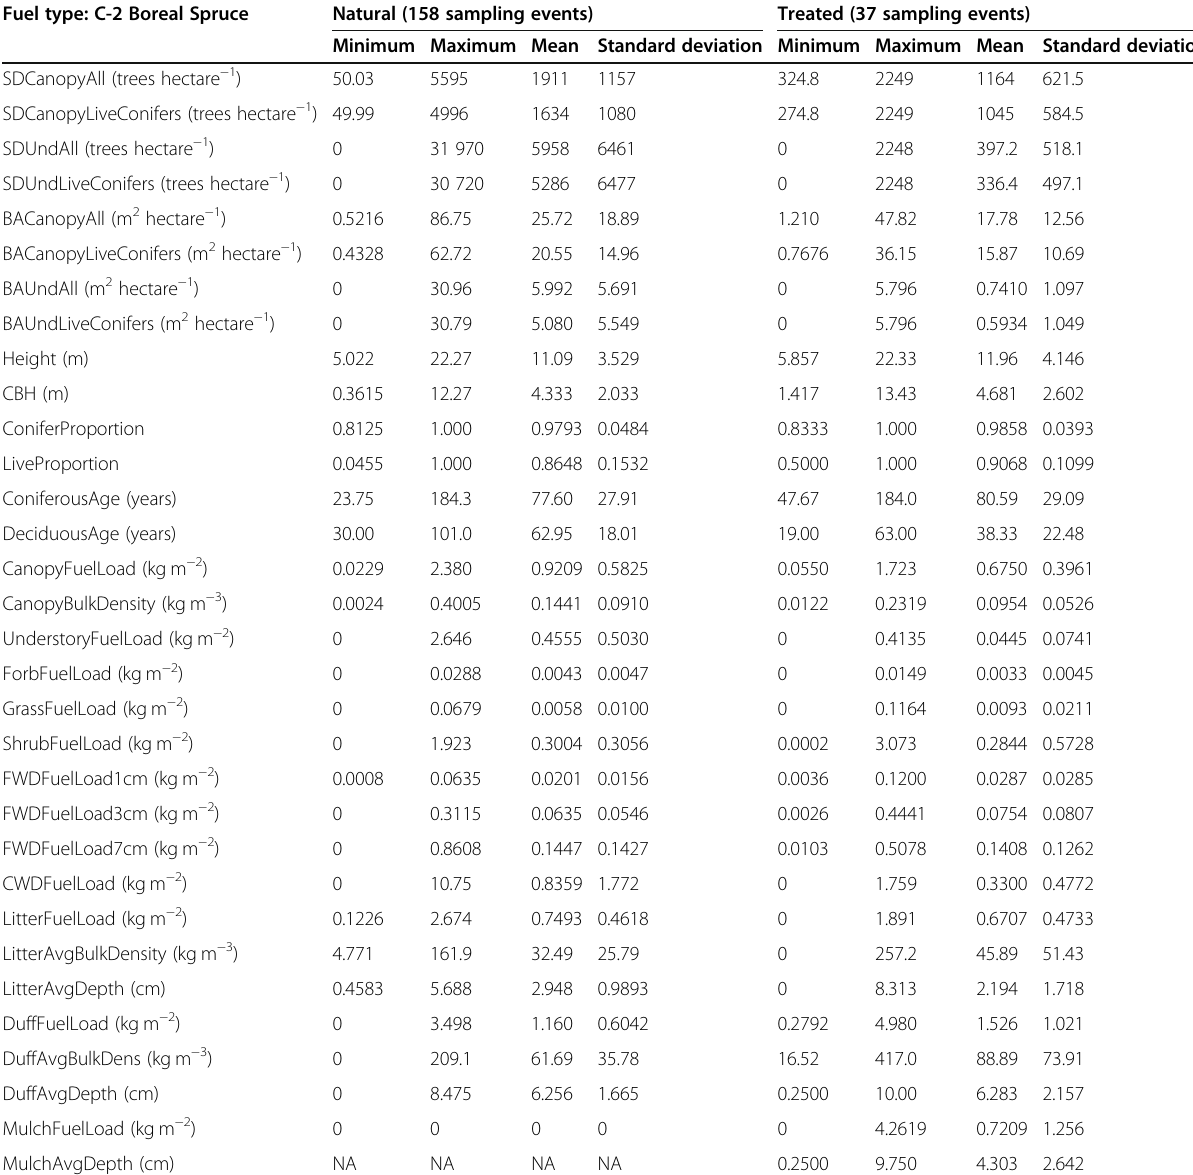
Table 2 Summary tables describing the minimum, maximum, mean, and standard deviation for several stand level features for each fuel type and treatment status by fuel type: C-2 Boreal Spruce. It should be noted that the number of sampling events for each category is not necessarily the number of sampling events contributing to the computation. For example, a sampling event might not have any deciduous trees and therefore would not contribute to the computation of statistics about the age of deciduous trees. A value of NA indicates that there were zero — or possibly one in the case of standard deviation — sampling events contributing to the computation. Values were rounded to four significant figures, up to four decimal